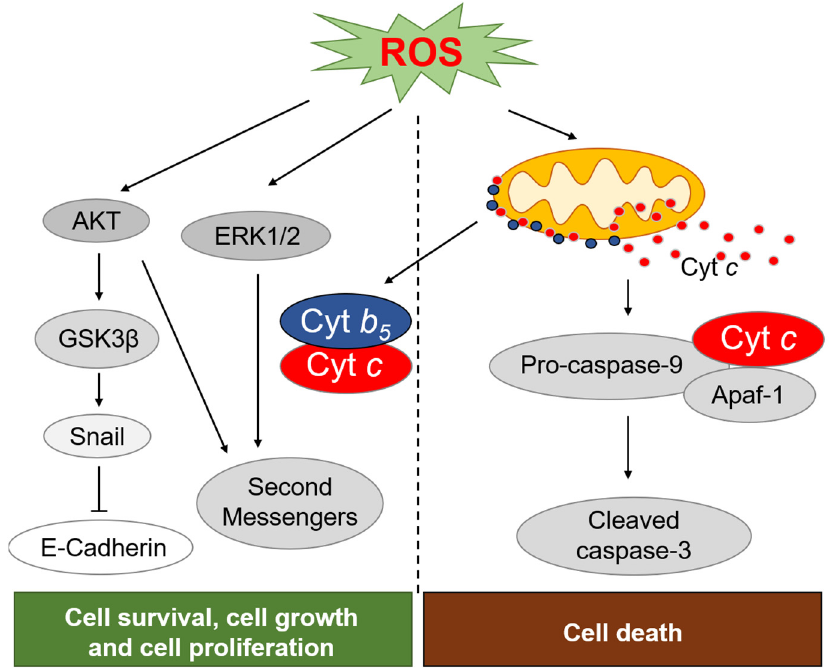
Figure 6. Co-IP verified the interaction of Cyt b 5 -Cyt c in MDA-MB-231 cells. ( a ) Cyt b 5 and Cyt c were co-expressed in MDA-MB-231 cells and in MDA-MB-231 cells with overexpressed Cyt b 5 . ( b , c ) Cell extracts were incubated with Cyt c antibody ( b ) and Cyt b 5 antibody ( c ). The immune complexes were precipitated by protein A/G beads and Cyt b 5 /Cyt c was analyzed with western blot. Moreover, the interaction of Cyt b 5 with Cyt c may block the interaction of Cyt c with Apaf-1. Similar to Cyt b 5 , the Apaf-1 surface is enriched with negatively charged residues of Asp and Glu. As predicted by the simulated Apaf-1-Cyt c complex, Cyt c may use similar positively charged Lys residues to interact with Apaf-1 such as K27, K72, K79, K86 and K87 [43]. Therefore, we speculated that in MDA-MB-231 cells, when Cyt b 5 is overexpressed, Cyt c will interact with it during the process of release from mitochondria to the cytoplasm, which prevents the continued binding of Cyt c to APAF-1, thereby preventing the apoptosis cascade. As shown in Scheme 1, we summarized the oxidative stress in triple-negative breast cancer and proposed the possible effects of Cyt b 5